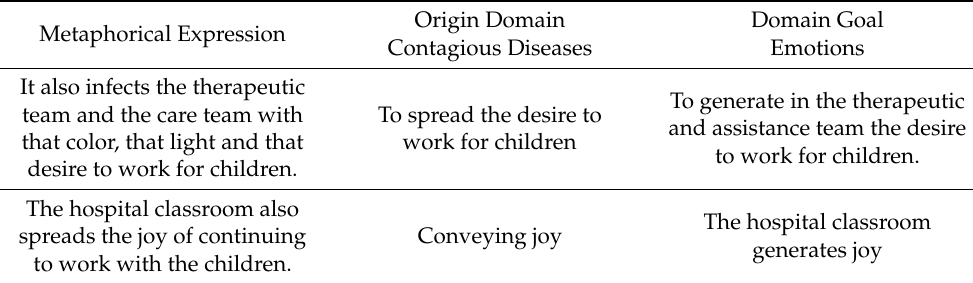
Table 5. Emotions are Contagious